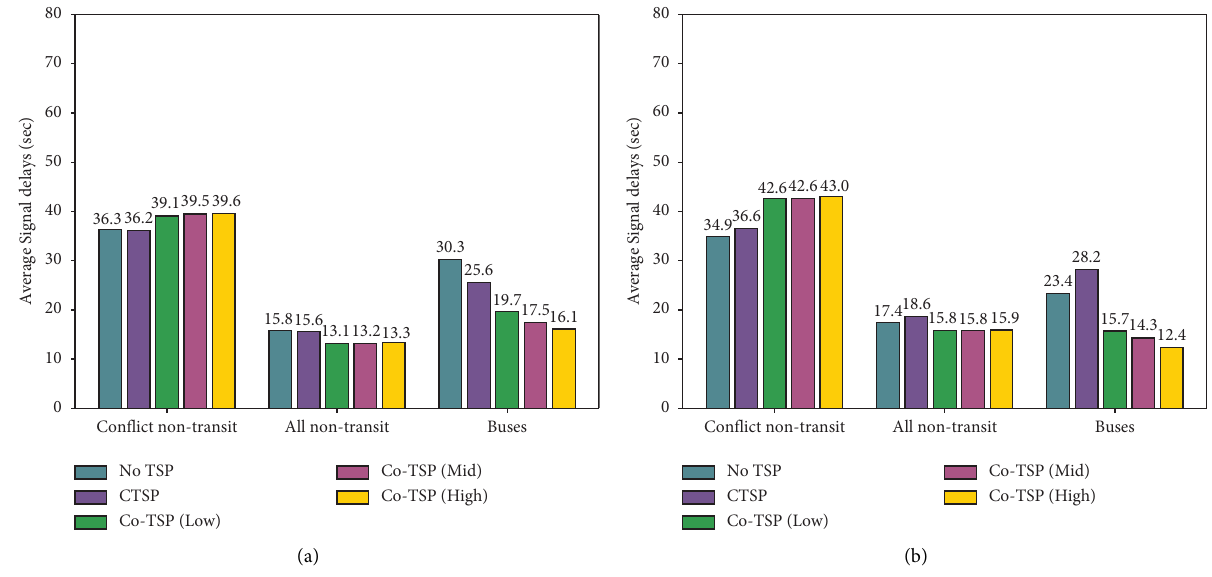
Figure 10: Performance under diferent congestion levels. (a) Low congestion level. (b) High congestion level.